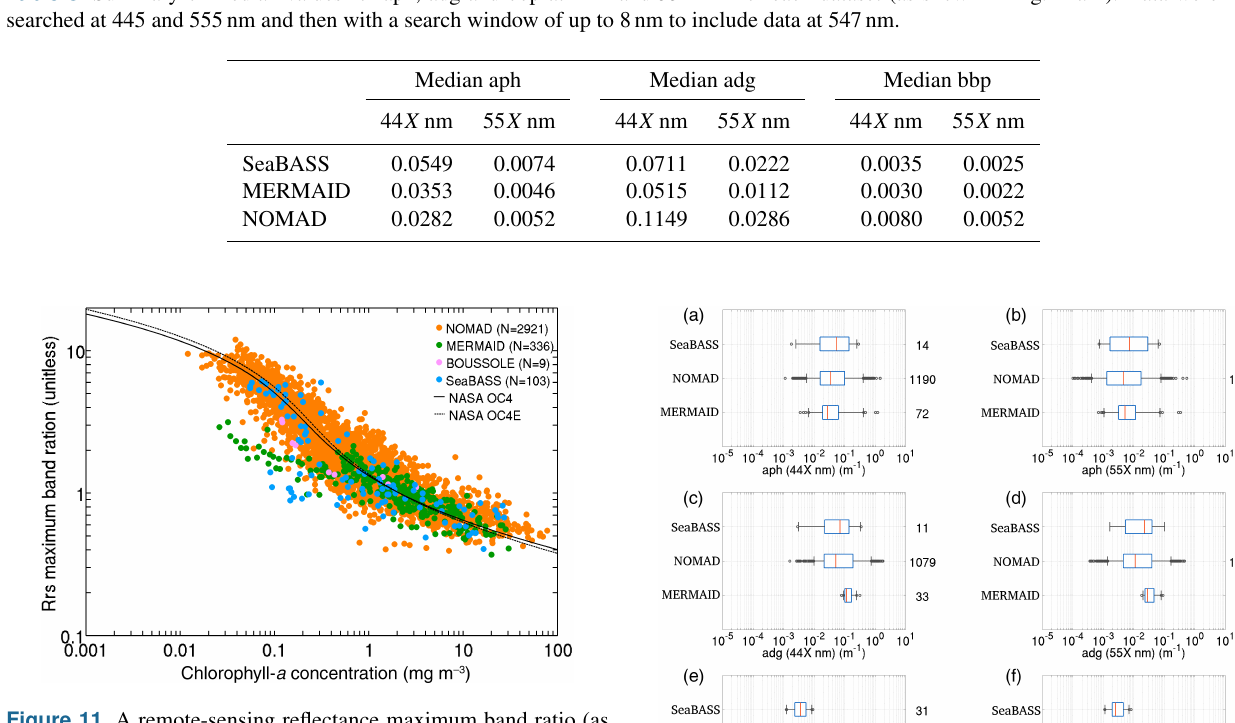
Figure 11. A remote-sensing reflectance maximum band ratio (as defined in text) ([443,490,510] / 555 or [443,490,510] / 560 if 555 not available) as a function of chlorophyll a concentration. All chlorophyll data were considered, but for a given station HPLC data were selected if available. Data within 2nm of the wave- lengths were used. For reference the solid and dotted line show the NASA OC4 and OC4E v6 standard algorithms, respectively (http://oceancolor.gsfc.nasa.gov/cms/atbd/chlor_a). The total num- ber of points was 3369, of which 86% were from NOMAD.